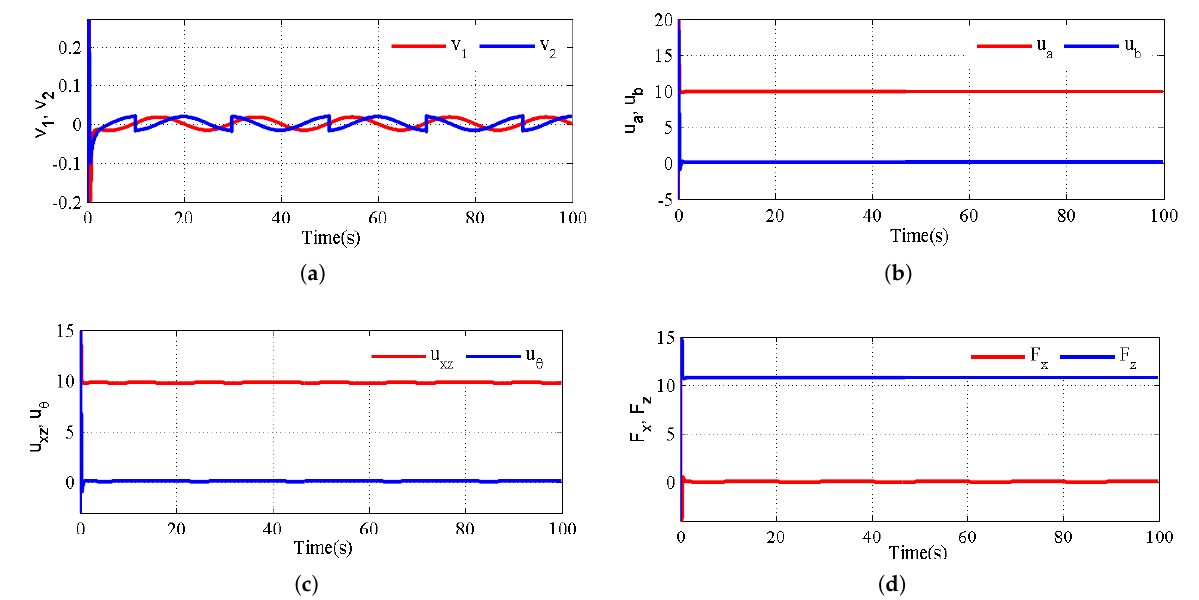
Figure 7. The control variables. ( a ) The control variables v 1 and v 2 ; ( b ) the control variables u a and u b ; ( c ) the control variables u xz and u θ ; and ( d ) the control variables F x and F z .